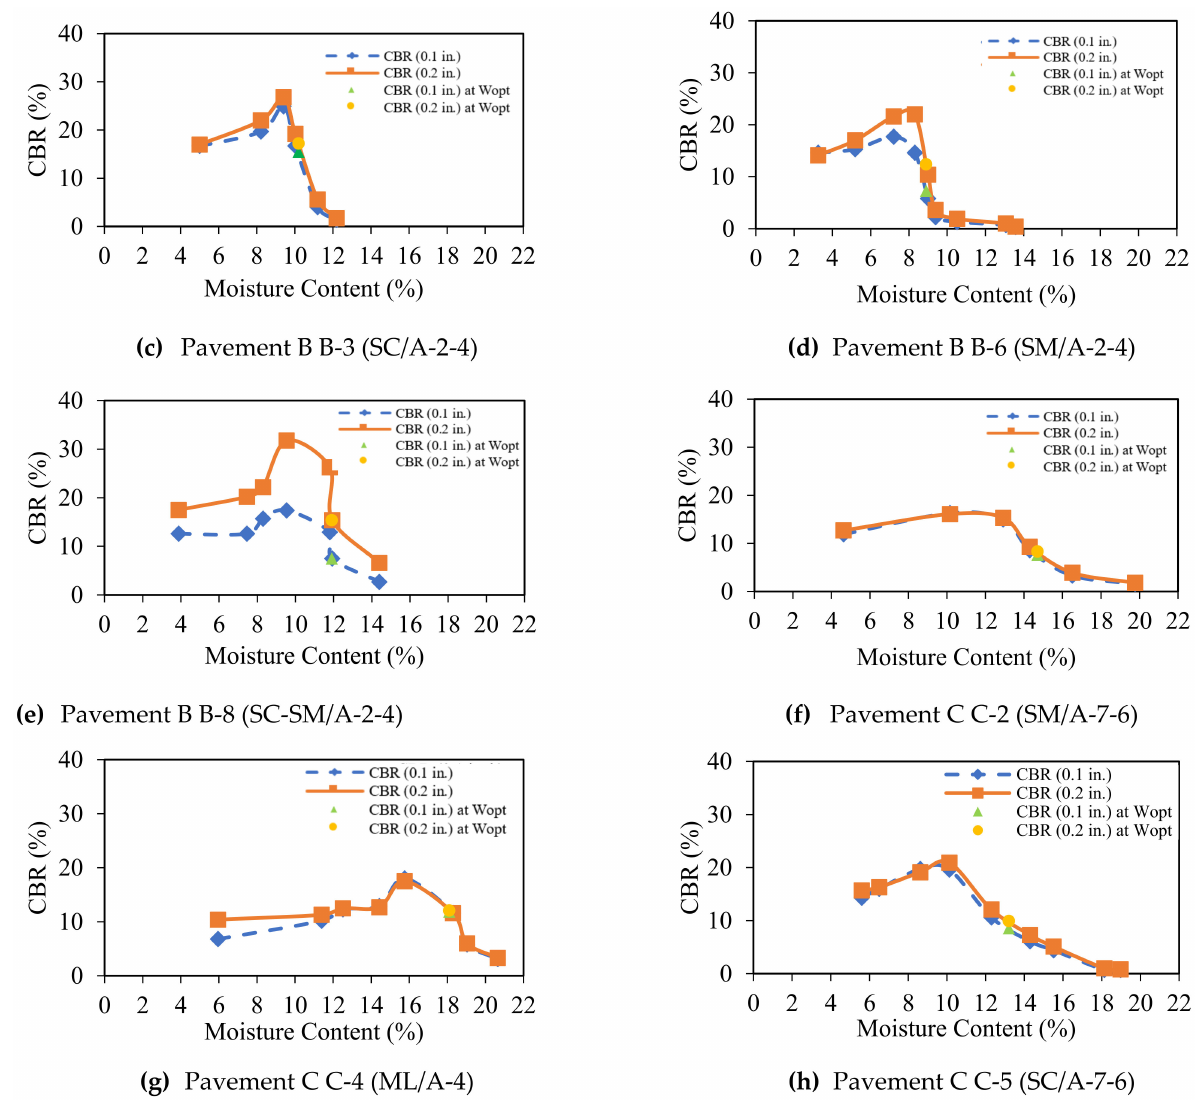
Figure 2. CBR With Moisture